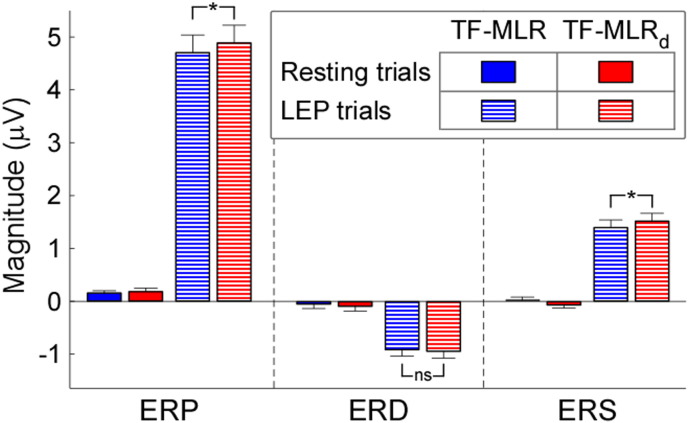
Comparison of single-trial magnitudes estimated using TF-MLR and TF-MLRd of LEP trials and resting EEG trials.Single-trial magnitudes of ERP (left), ERD (middle), and ERS (right) estimated using TF-MLR (blue) and TF-MLRd (red) from LEP trials (palisaded) and resting EEG trials (filled). For both TF-MLR and TF-MLRd, the magnitudes of ERP, ERD and ERS estimated from resting EEG trials are not significantly different from zero (p > 0.05 for all comparisons; one sample t test). Whereas the single-trial magnitudes of ERD estimated from LEP trials using TF-MLR and TF-MLRd are not significantly different, the single-trial magnitudes of ERP and ERS estimated from LEP trials using TF-MLR were significantly smaller than those estimated using TF-MLRd (p < 0.01 for both comparisons, paired sample t test).